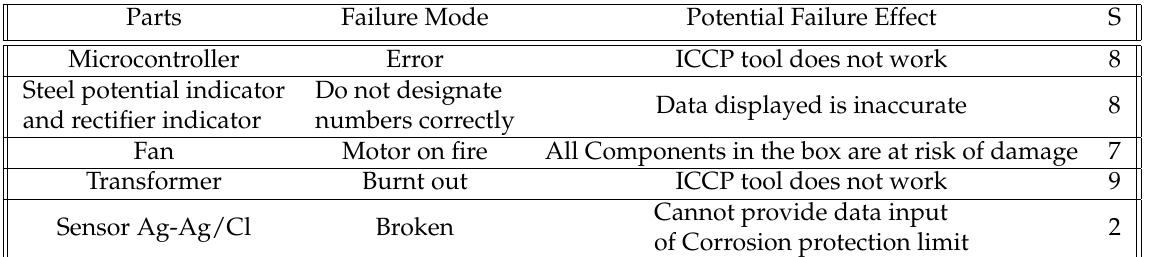
Table 2. Result of Severity Score for Failure in